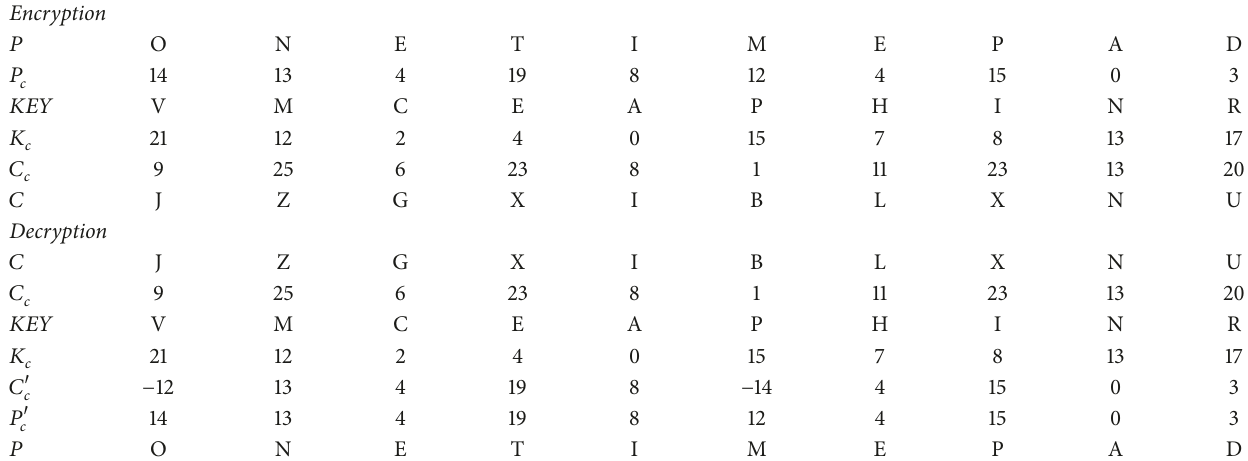
Table 1: Encryption and decryption process of conventional OTP cipher using modular arithmetic 26. 𝑃 : plaintext, 𝑃 𝑐 : plaintext code, 𝐾𝐸𝑌 : secret key, 𝐾 𝑐 : key code, 𝐶 : ciphertext, 𝐶 𝑐 = (𝑃 𝑐 + 𝐾 𝑐 ) mod (26) and 𝐶 󸀠 𝑐 = (𝐶 𝑐 − 𝐾 𝑐 ) mod (26). From 𝐶 󸀠 𝑐 , 𝑃 󸀠 𝑐 is obtained as follows: 𝑃 󸀠 𝑐 = 𝐶 󸀠 𝑐 if 𝐶 󸀠 𝑃 󸀠 = 𝐶 󸀠 + 26 . 𝑐 is +ve; otherwise 𝑐 𝑐